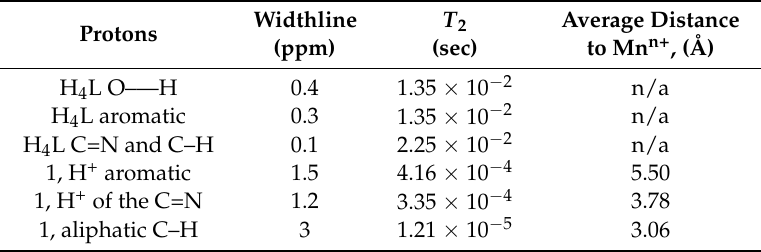
Table 5. Broad lines of the chemical shifts, relaxation times, and average distances between manganese ions and protons for H 4 L and 1